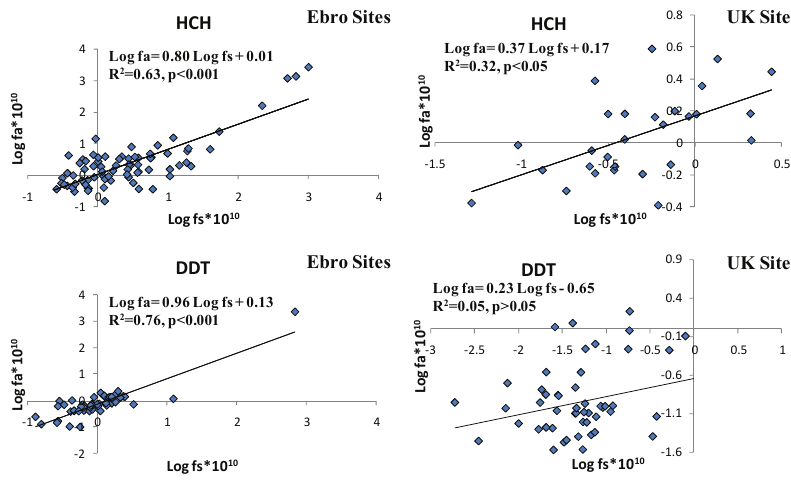
Fig. 6. Fugacity in soil ( f s ) versus fugacity in air ( f a ) for all HCH ( α -HCH, γ -HCH, β -HCH, δ -HCH) isomers and all DDT metabolites (p,p 0 -DDE, p,p 0 -DDD, o,p 0 -DDT and p,p 0 -DDT) for sampling sites in Spain (Figures on the left) and sampling sites in UK (Figures on the right.